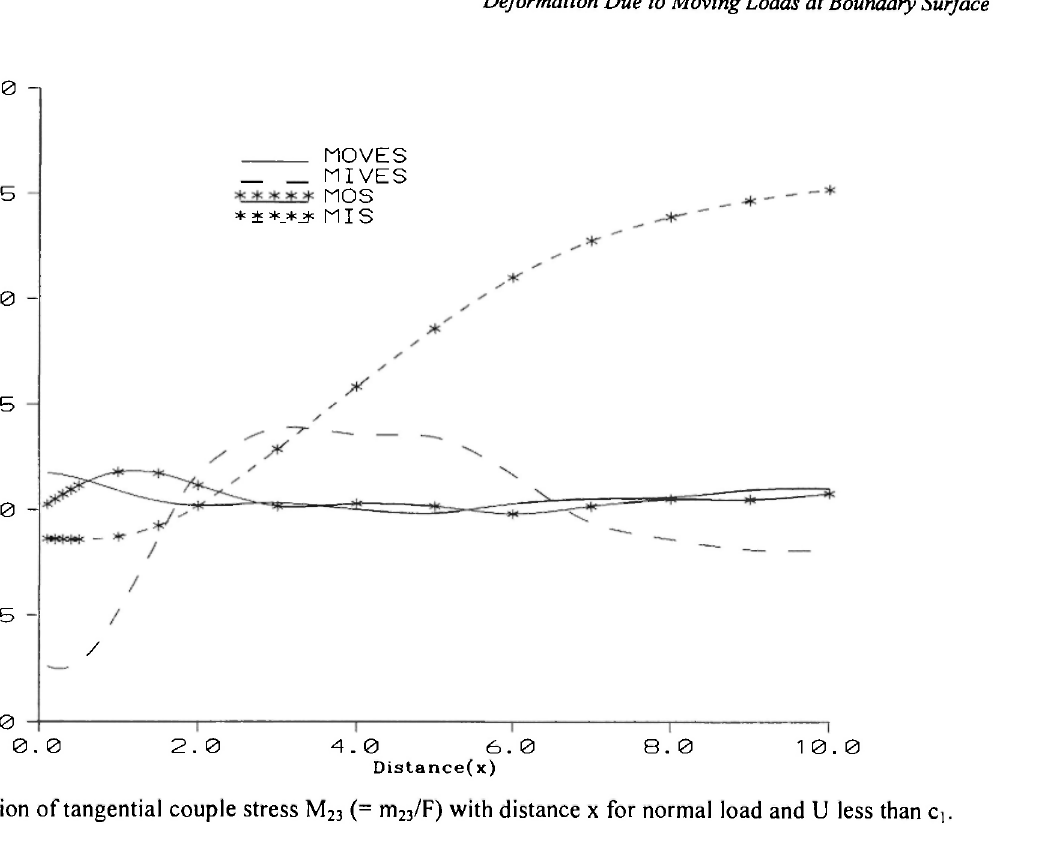
Fig. 15: Variation of tangential couple stress M 23 (= m 23 /F) with distance χ for normal load and U less than q.